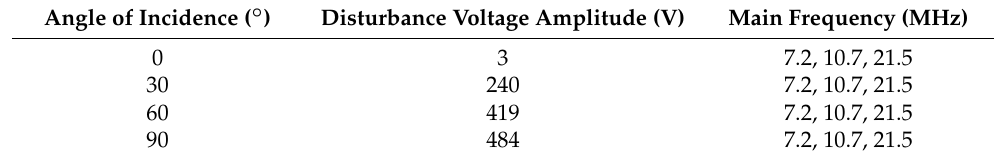
Table 2. The influence of the vertical component of electric field on radiated disturbance. Angle of Incidence ( ◦